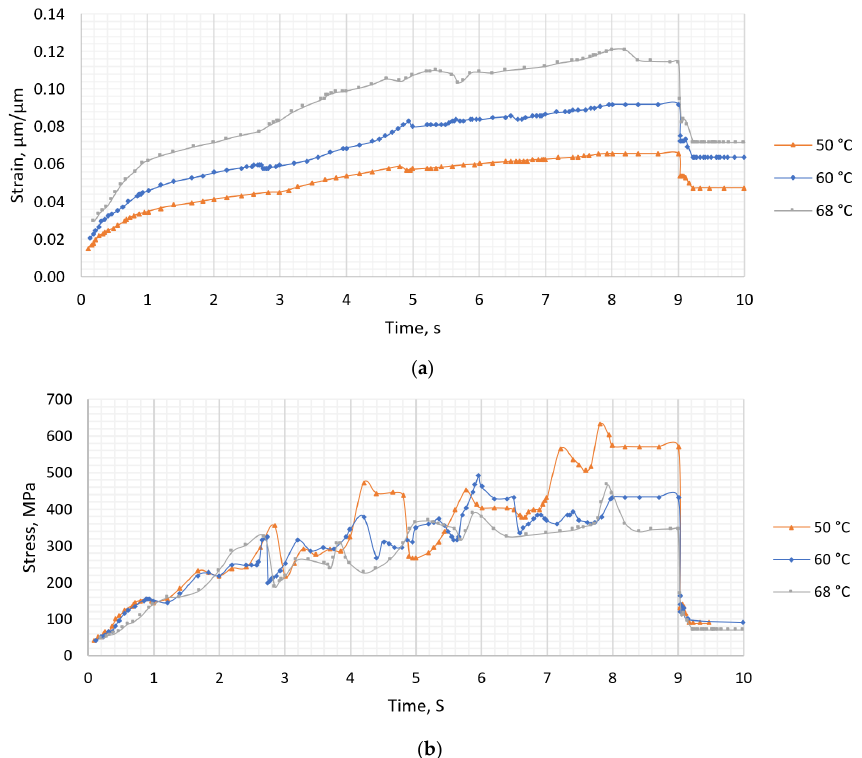
Figure 5. Results of simulation: ( a ) Equivalent elastic strain; ( b ) Equivalent stress.